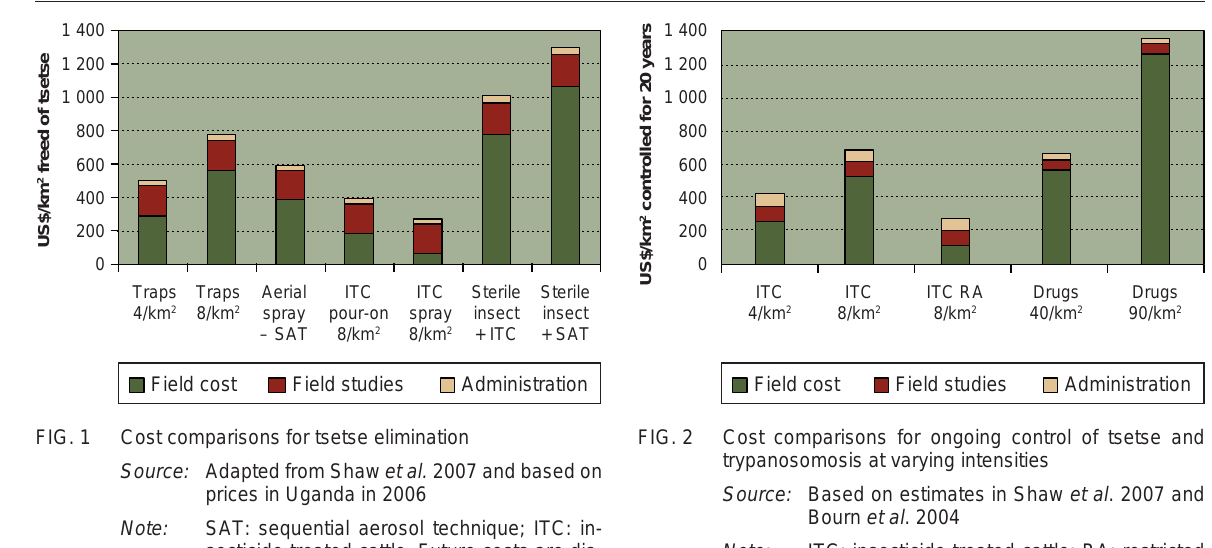
FIG. 2 FIG. 1 Cost comparisons for tsetse